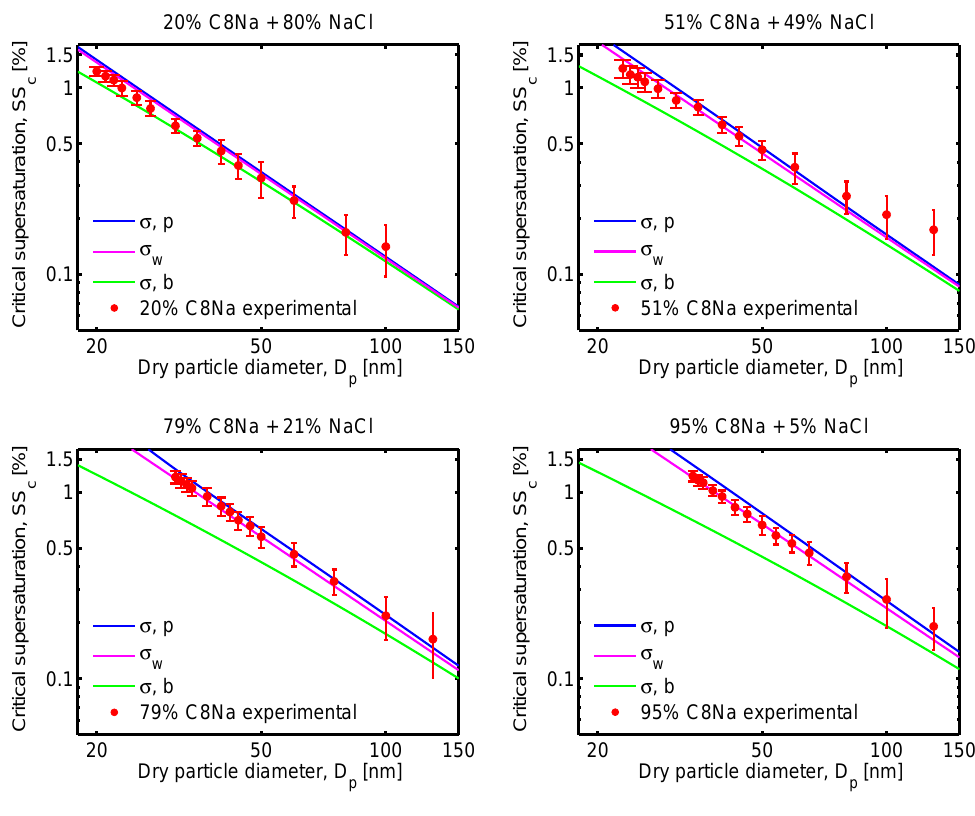
Fig. 2. Critical supersaturations ( SS c [ % ] ) as functions of dry particle diameter ( D p [nm]) for particles with sodium octanoate (C8Na) in dry mass fractions ( W p, C8Na ) of (a) 20%, (b) 51%, (c) 79%, and (d) 95%, measured in experiments and modeled with the three different surfactant representations ( σ,p , σ,b , and σ w